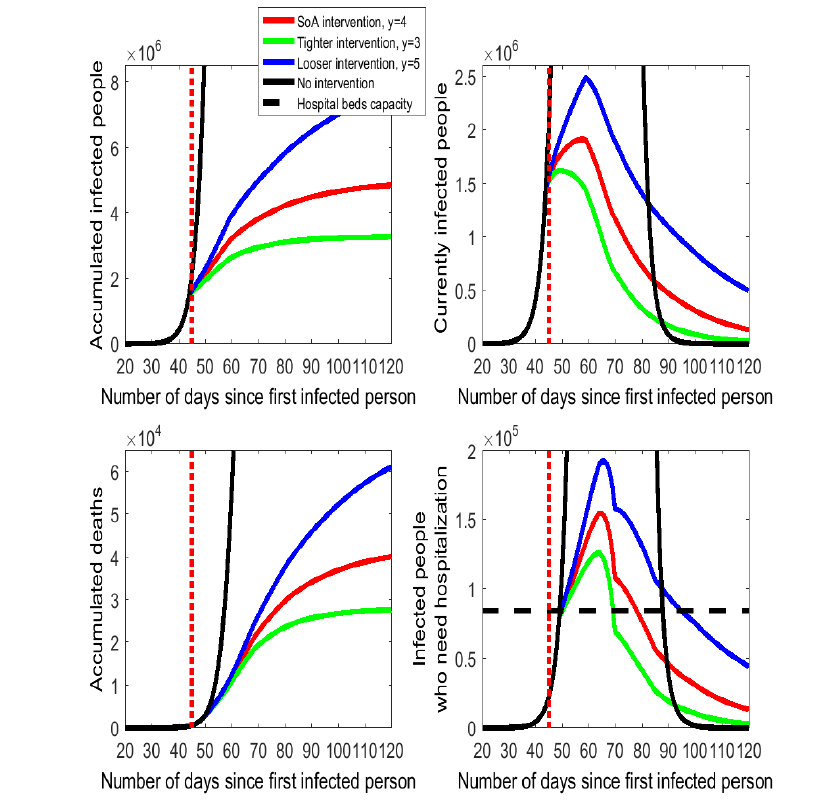
Figure 3. Alternative intensities for the isolation policy in Spain following the COVID-19